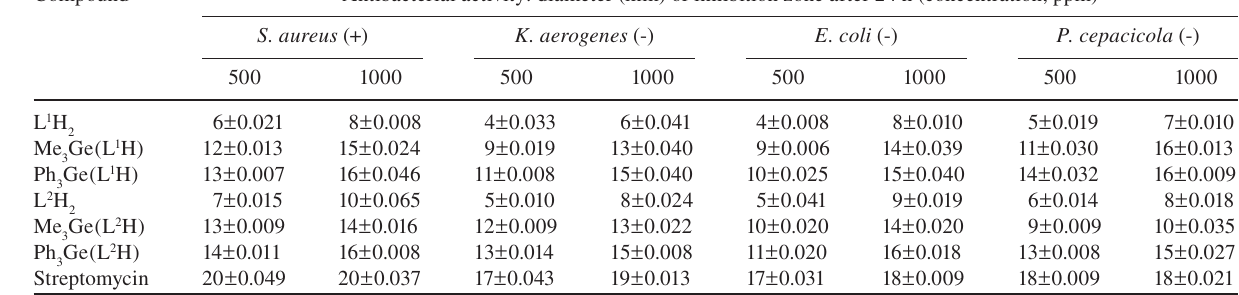
Table 4 Antibacterial screening data of ligands and their complexes synthesized through thermal and microwave methods. Compound